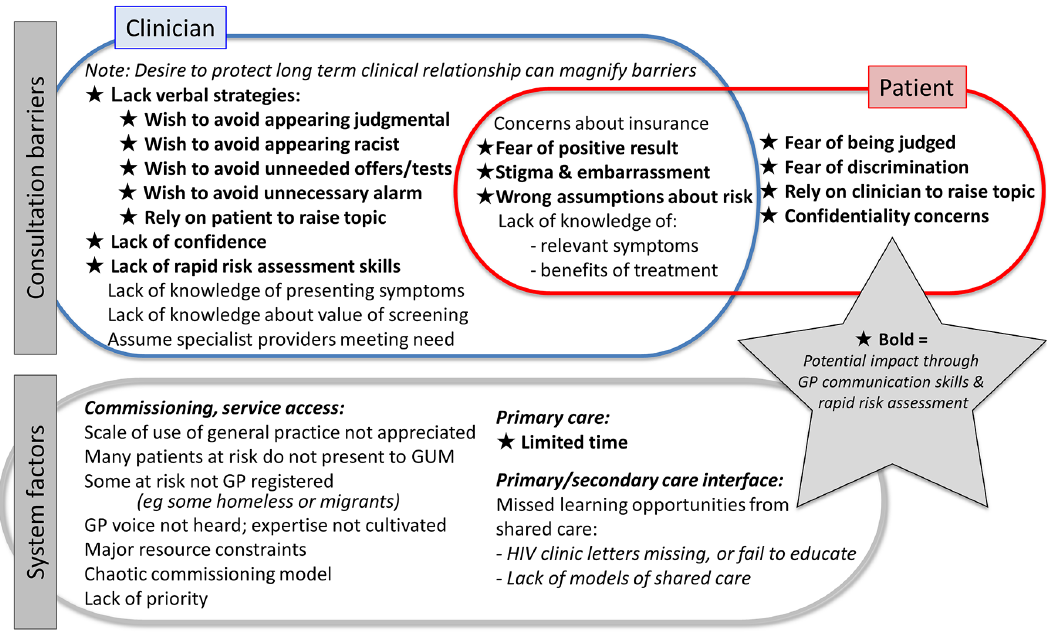
Fig 1. Barriers to HIV testing in primary health